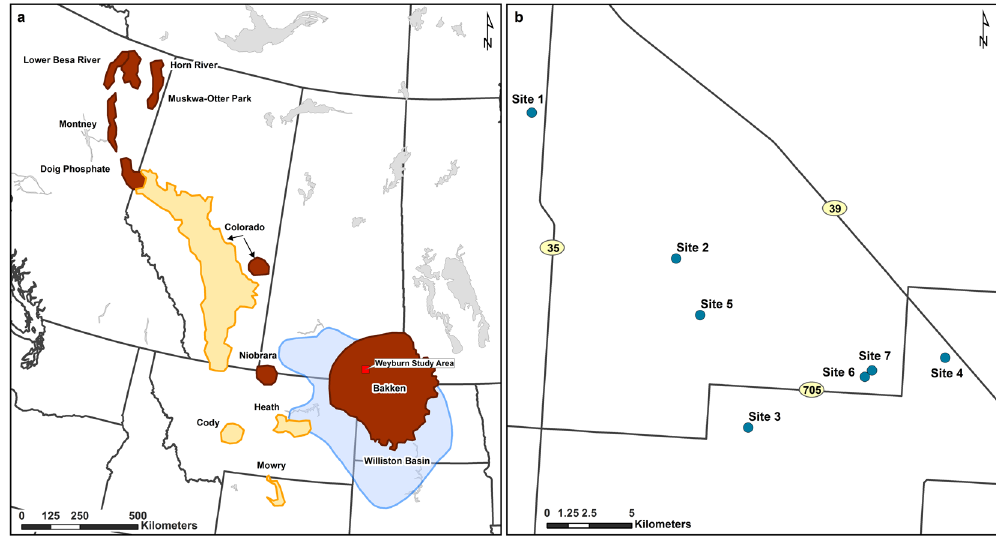
Figure 1. Location map. ( a ) Extent of the Western Canadian Sedimentary Basin (yellow), Williston Basin (blue) 43 , and Bakken shale play (orange) 3 in northwestern USA and western Canada, and location of study area. ( b ) Location of Sites 1–4 15 , Site 5 32 , and Sites 6 and 7. Highways are shown as solid black lines in ( b ). Adapted with permission from ref. 3 and ref. 54. Copyright 2014 American Chemical Society and 2012 Springer International, respectively. Map was created with ArcMap version 10.5 (http://esri.ca/en/products/whats-new-